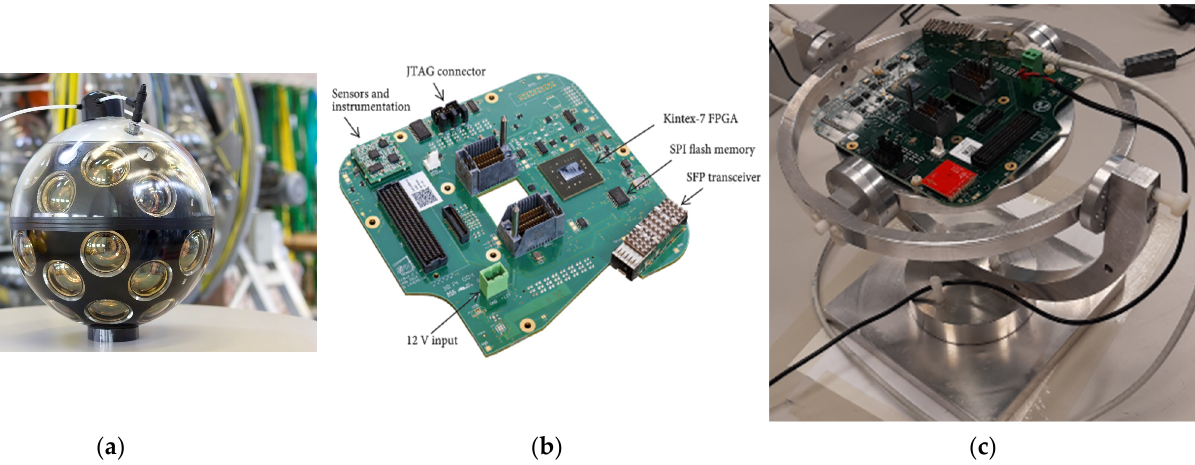
Figure 1. The KM3NeT DOM, CLB and CLB onshore calibration test: ( a ) DOM mounted; ( b ) CLB unmounted of the DOM; ( c ) CLB mounted in the “Wobbling” test bench.